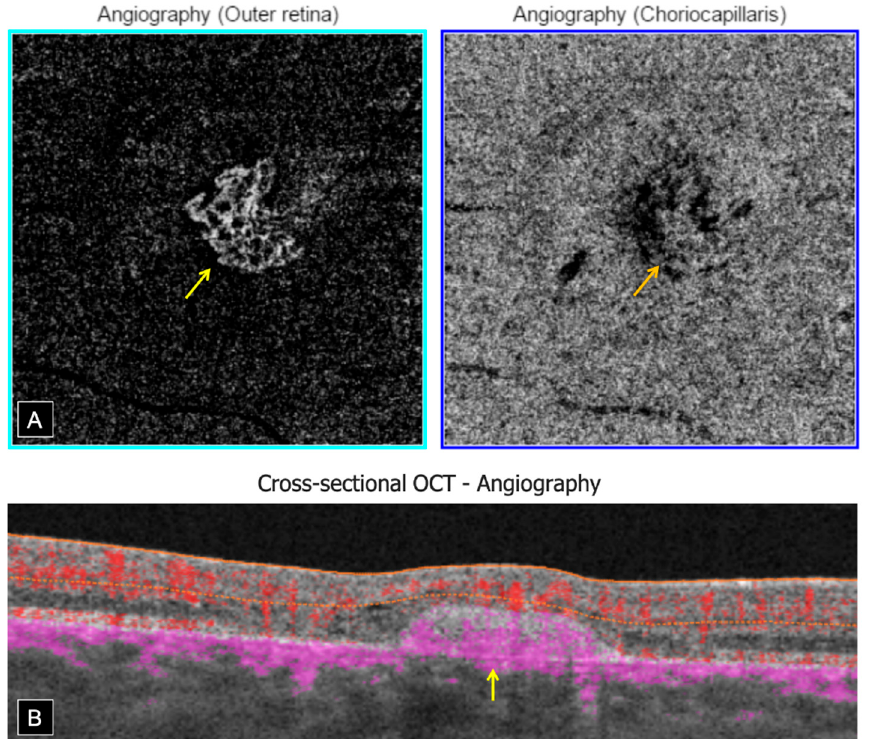
Figure 4. Swept source OCT-Angiography of CNV in the RE. ( A )—En face OCT-A (3 × 3 mm): Well-defined high-flow vascular network at the level of the OR slab (yellow arrow) with a projection in the CC slab (orange arrow). ( B )—Cross-sectional OCT-A: High-flow signal within subretinal hyper-reflective lesion (yellow arrow).